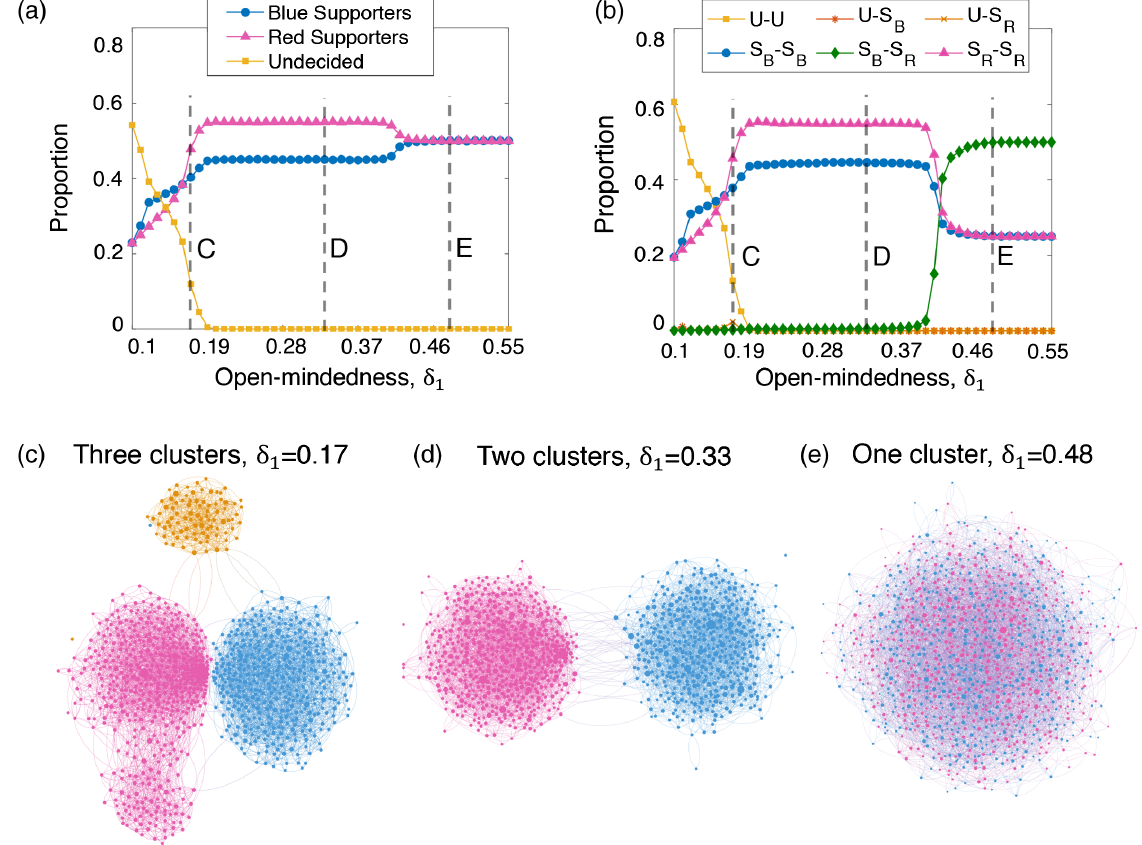
FIG. 2. Modeling the emergence of echo chambers. The relationship between the degree of ideological segregation and population identity scope (i.e., open-mindedness) largely influences the nature and outcome of public discourse. Shifts in identity scope are alone sufficient to drastically change the (a) breakdown of candidate support and (b) the distribution of ties between and within supporter groups. The stable network structures of simulations corresponding to three different identity scope values (c) – (e) show how open- mindedness effects the emergence of echo chambers. Parameters: Campaign effort Ω T ¼ 0 . 5 , position of viewpoint blue θ 1 ¼ 0 . 2 , position of viewpoint red θ 2 ¼ 0 . 7 , influence of candidate μ 1 ¼ 0 . 5 , and influence of discussion partner μ 2 ¼ 0 . 5 . All simulations begin from an Erdös – R´enyi (ER) random graph; the simulations for (a) and (b) have network size N ¼ 10 4 and average degree h k i ¼ 6 . Simulation results are averaged over 100 independent runs. In the simulations that generate (c) – (e), N ¼ 10 3 and h k i ¼ 6